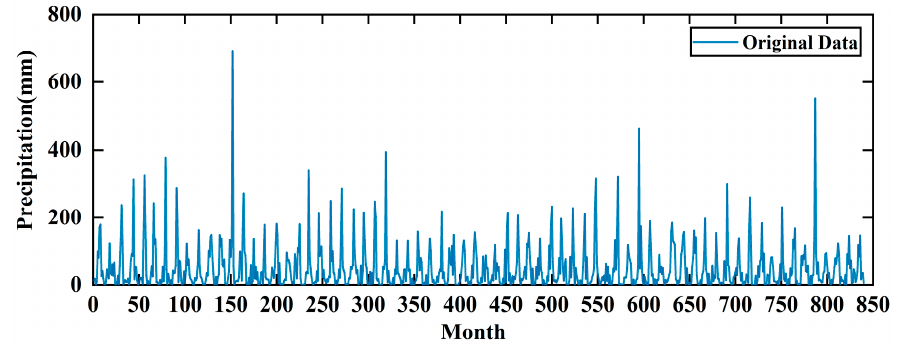
Figure 4. Monthly precipitation of Zhengzhou Station during 1951–2020.